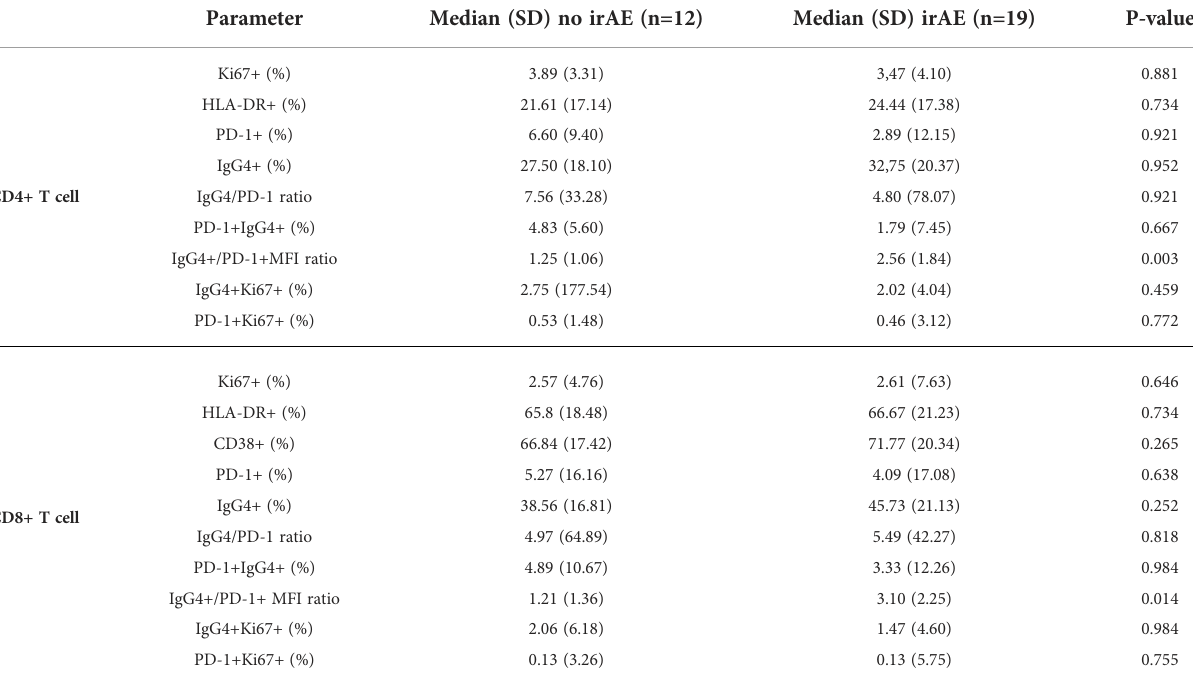
TABLE 1 Percentage of proliferation and activation markers positivity in total and therapeutic antibody-bound CD4 and CD8 T cells from patients with or without immune related adverse events.